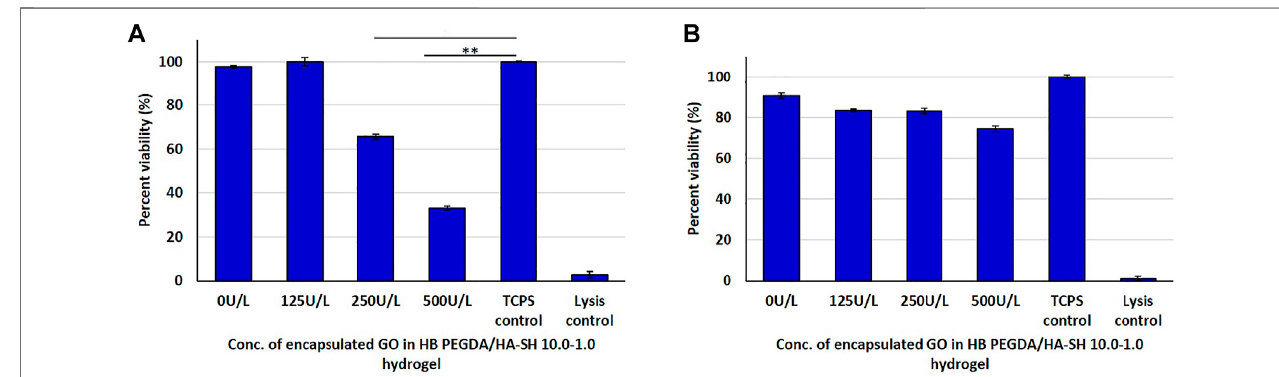
FIGURE 5 | Post 24 h cell viability data of L929 cells interacting with H 2 O 2 -releasing HB PEGDA/HA-SH 10.0 – 1.0 hydrogels containing different amounts of GO (25 – 500 U/L)andconstantGamount(2.5% w/w)usingthequantitativeCTBassay: (A) directcontact:250 U/LandTCPScontrol(*indicates p value (cid:2) 0.0006);500 U/L and TCPS control (** indicates p value (cid:2) 0.0001); (B) indirect contact tests.